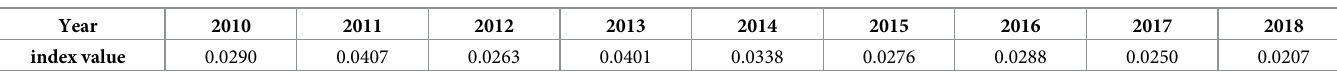
Table 5. The ecological pressure index of water